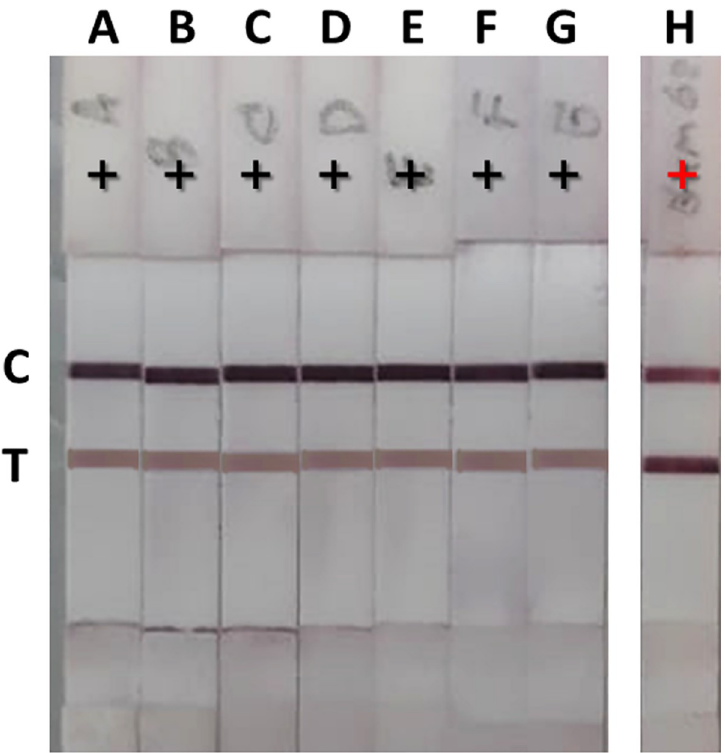
Fig 8. The effect of non– T . marneffei mannan interference with GNA-MAb 4D1 sandwich ICT strip. T . marneffei positive urine was spiked with various concentrations of GXM of C . neoformans (serotype A). A; T . marneffei positive urine, B–G labels indicated the concentrations of C . neoformans GXM from 1,000, 500, 250, 125, 62.5, and 31.25 ng/ ml, respectively, were spiked in T . marneffei positive urine. H; to confirm GXM presence in urine, in-house sandwich ICT strip was established for detecting C . neoformans capsular antigen at the GXM concentration of 31.25